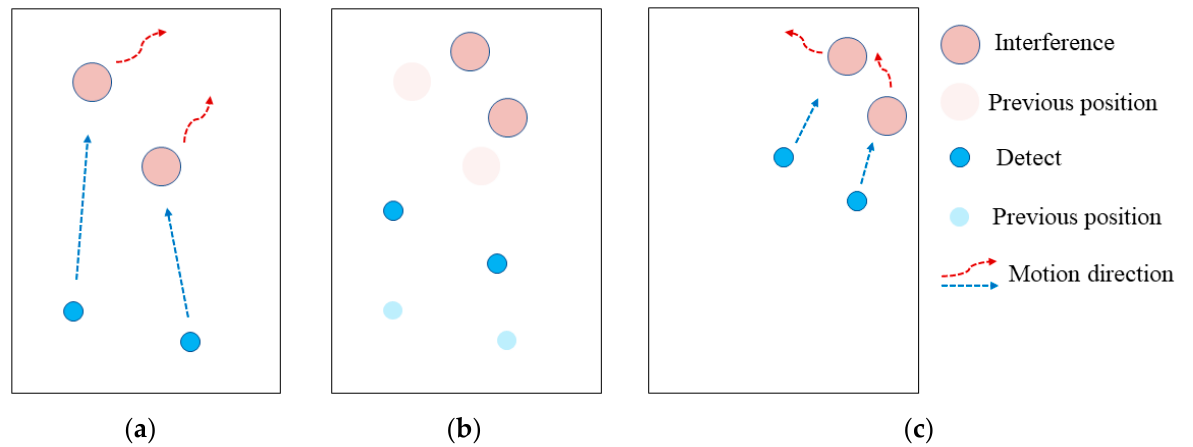
Figure 8. Confrontation process diagram of multi-agent confrontation environment. ( a ) Motion trend of the detection agent and the interference agent. ( b ) Action of the detection agent and the interference agent. ( c ) Action process of the detection agent and the interference agent.